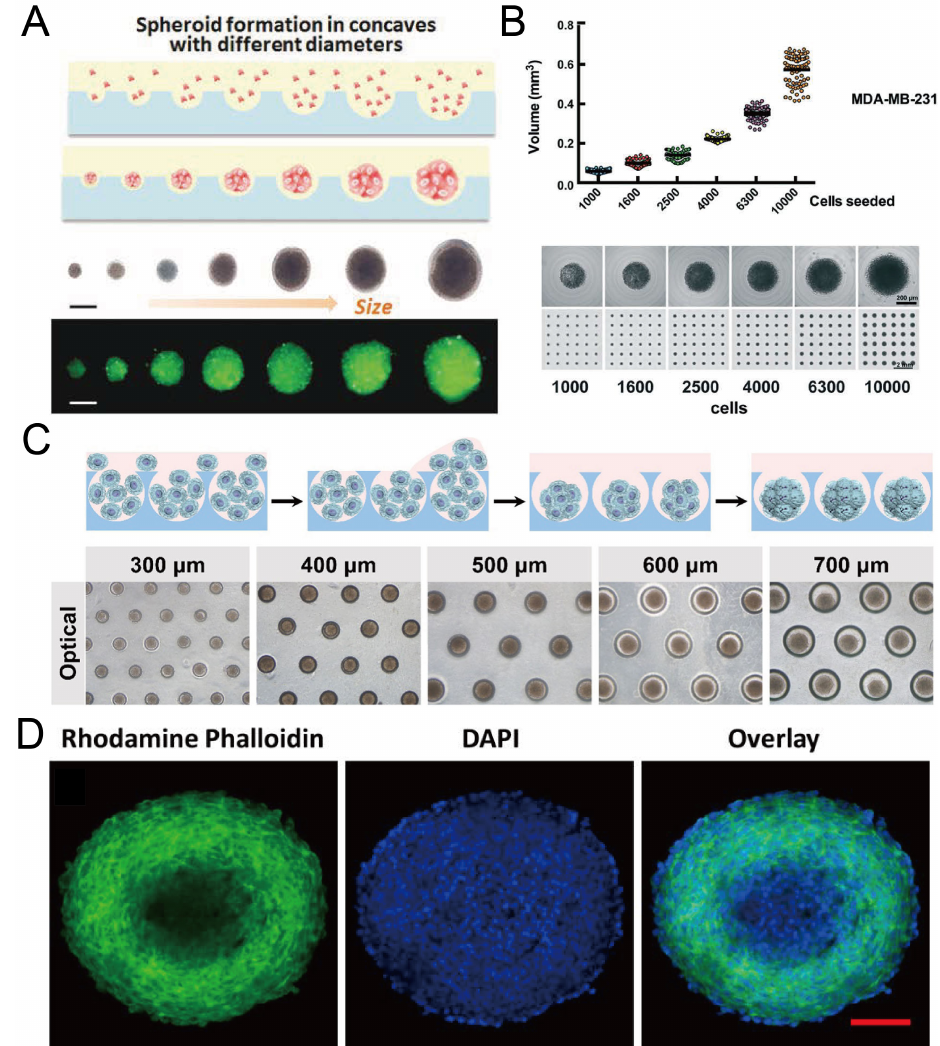
Figure 12. Formation of cancer spheroids in concave microwells. ( A ) Glioma spheroids of different diameters can be formed in concave microwells of different sizes [37]. Reprinted (adapted) from [37]. Copyright (2015) with permission from John Wiley and Sons. ( B ) The size of breast cancer spheroids can be controlled by the seeding density (of MDA-MB-231 cells) [81]. Reprinted (adapted) from [81] under the terms of the Creative Commons CC BY license. ( C ) Schematic view of HepG2 spheroid formation, and experimental pictures of HepG2 spheroids formed in concave microwells of different diameters [63]. Reprinted (adapted) from [63]. Copyright (2020) with permission from John Wiley and Sons. ( D ) Fluorescent images of an EMT-6 (mammary carcinoma cell line) spheroid of diameter above 400 µm, stained by DAPI and rhodamine phalloidin [78]. Scale bar: 100 µm. Reprinted (adapted) from [78]. Copyright (2014) with permission from American Chemical